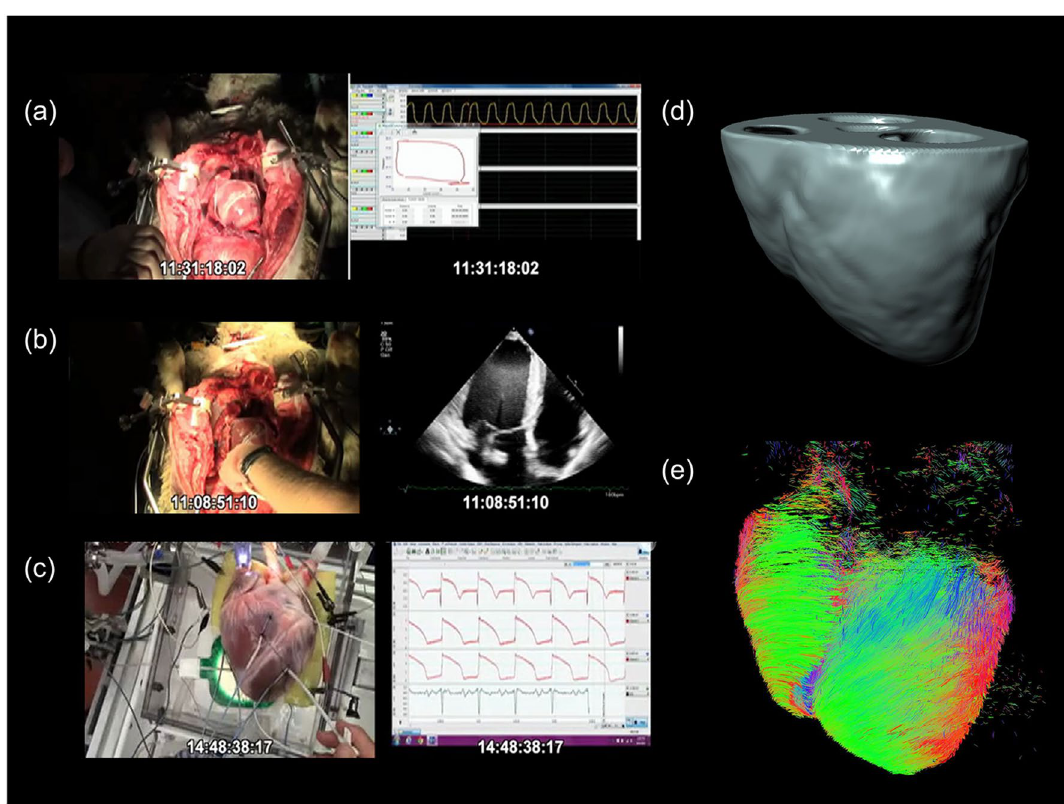
Figure 2. Data collection from a single heart for in silico model development. ( a ) Pressure volume loops, ( b ) echocardiography, and ( c ) epicardial monophasic action potentials were obtained in vivo and subsequently ex situ. ( d ) MRI and ( e ) DTMRI were employed to obtain accurate descriptions of anatomy (for FE mesh construction) and myofiber directions (to assign material heterogeneity and